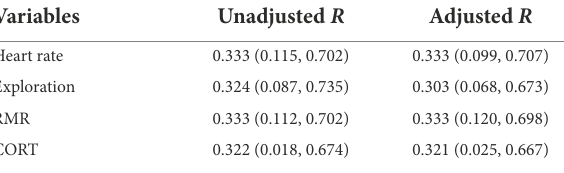
TABLE 1 Unadjusted and adjusted repeatability ( R ) estimates with 95% CI .